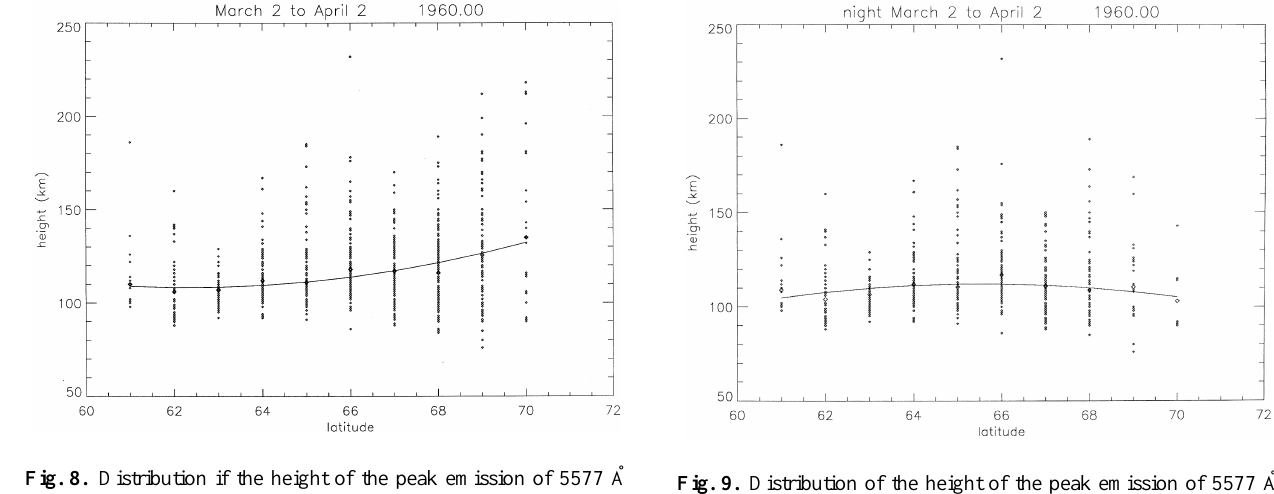
Fig. 9. Distribution of the height of the peak emission of 5577 ˚A [OI] emission as a function of dipole latitude for only the nighttime data (solar depression angle > 18 ◦ from the 1960 observations. The line is a second order polynomial least squares fit and the diamonds are median